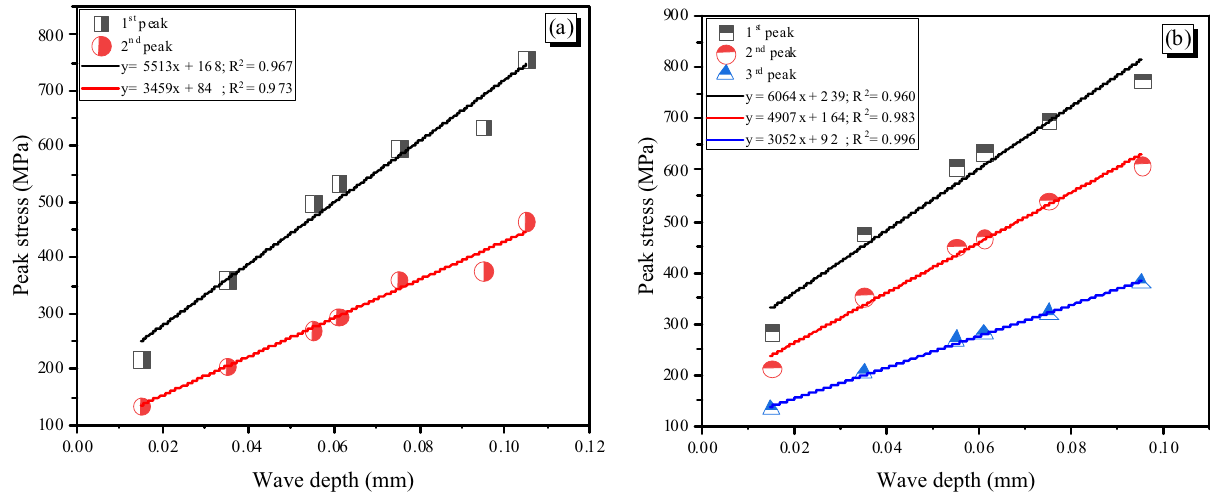
Figure 27: Relationship between pullout stress and wave depth of three - and four - wave fi bers: ( a ) 3 waves and ( b ) 4